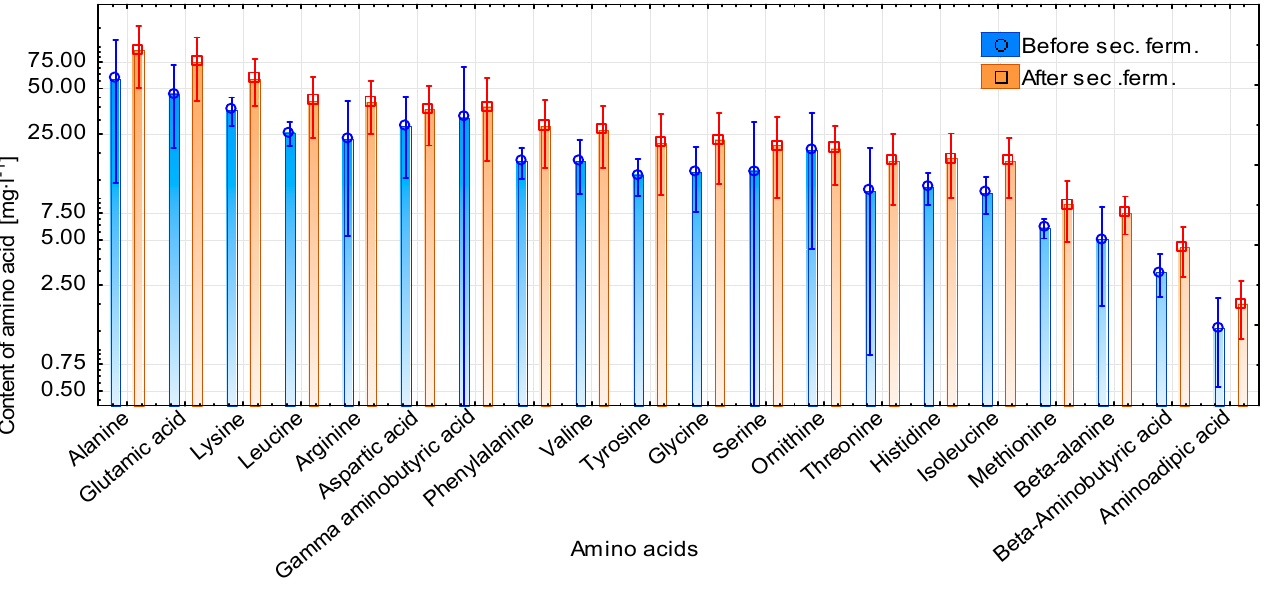
Figure 2. Comparison of average amino acid content categorized before and after secondary fer- mentation.